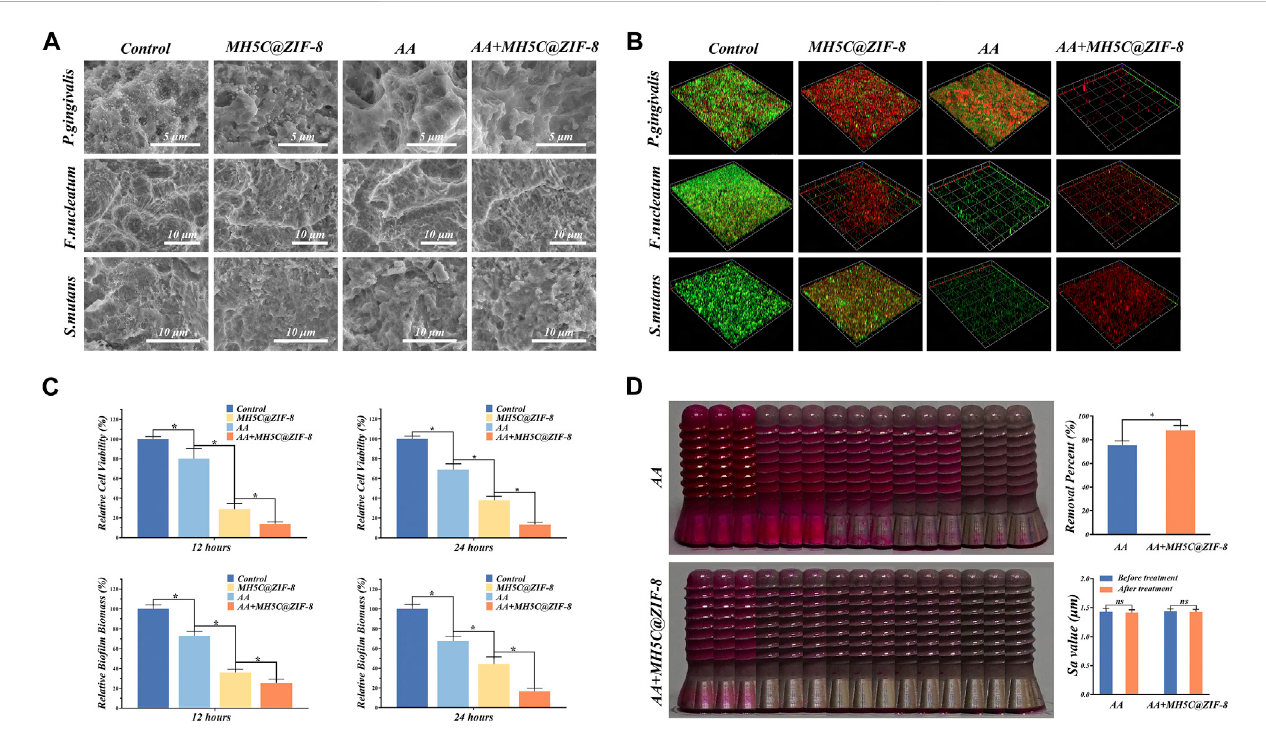
FIGURE 4 Decontamination ef fi ciencies of the synergistic therapy using erythritol air-polishing coupled with MH5C@ZIF-8 NPs. (A) SEM morphologies of F. nucleatum , P. gingivalis , and S. mutans after different debridement. (B) Representative 3D live/dead images of single-species bio fi lms in different groups. (C) Bacterial activity and bio fi lm biomass in each group with different treatments. (D) Assessment of the residual stains from digital photo as well as the surface roughness after 60 s of air abrasion with or without the pre-treatment of MH5C@ZIF-8